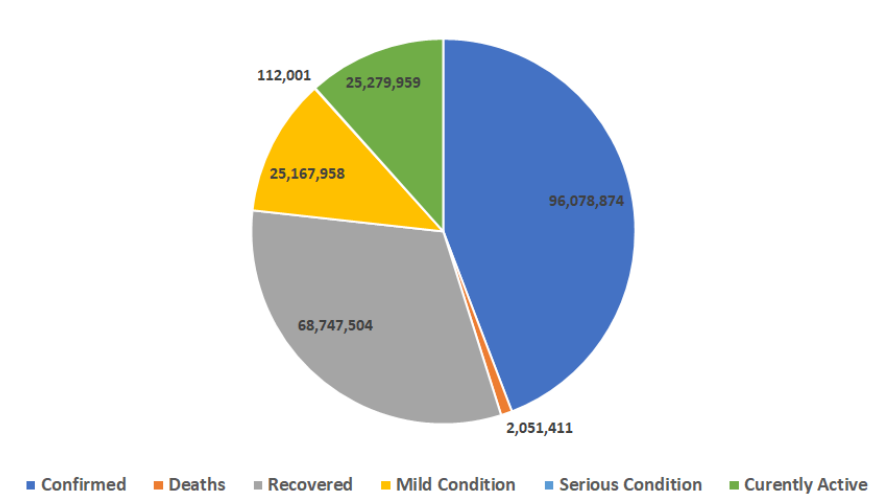
Figure 2. Global statistics of COVID-19 till 9